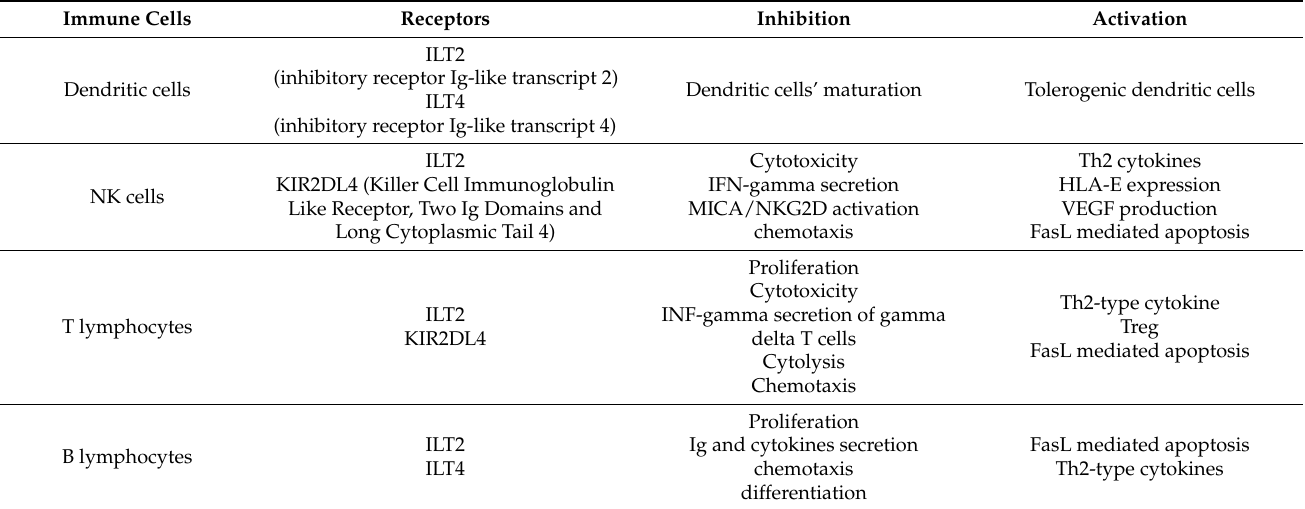
Table 1. Tolerogenic functions of HLA-G—an interaction of HLA-G with immune system cells [62,63]. Immune